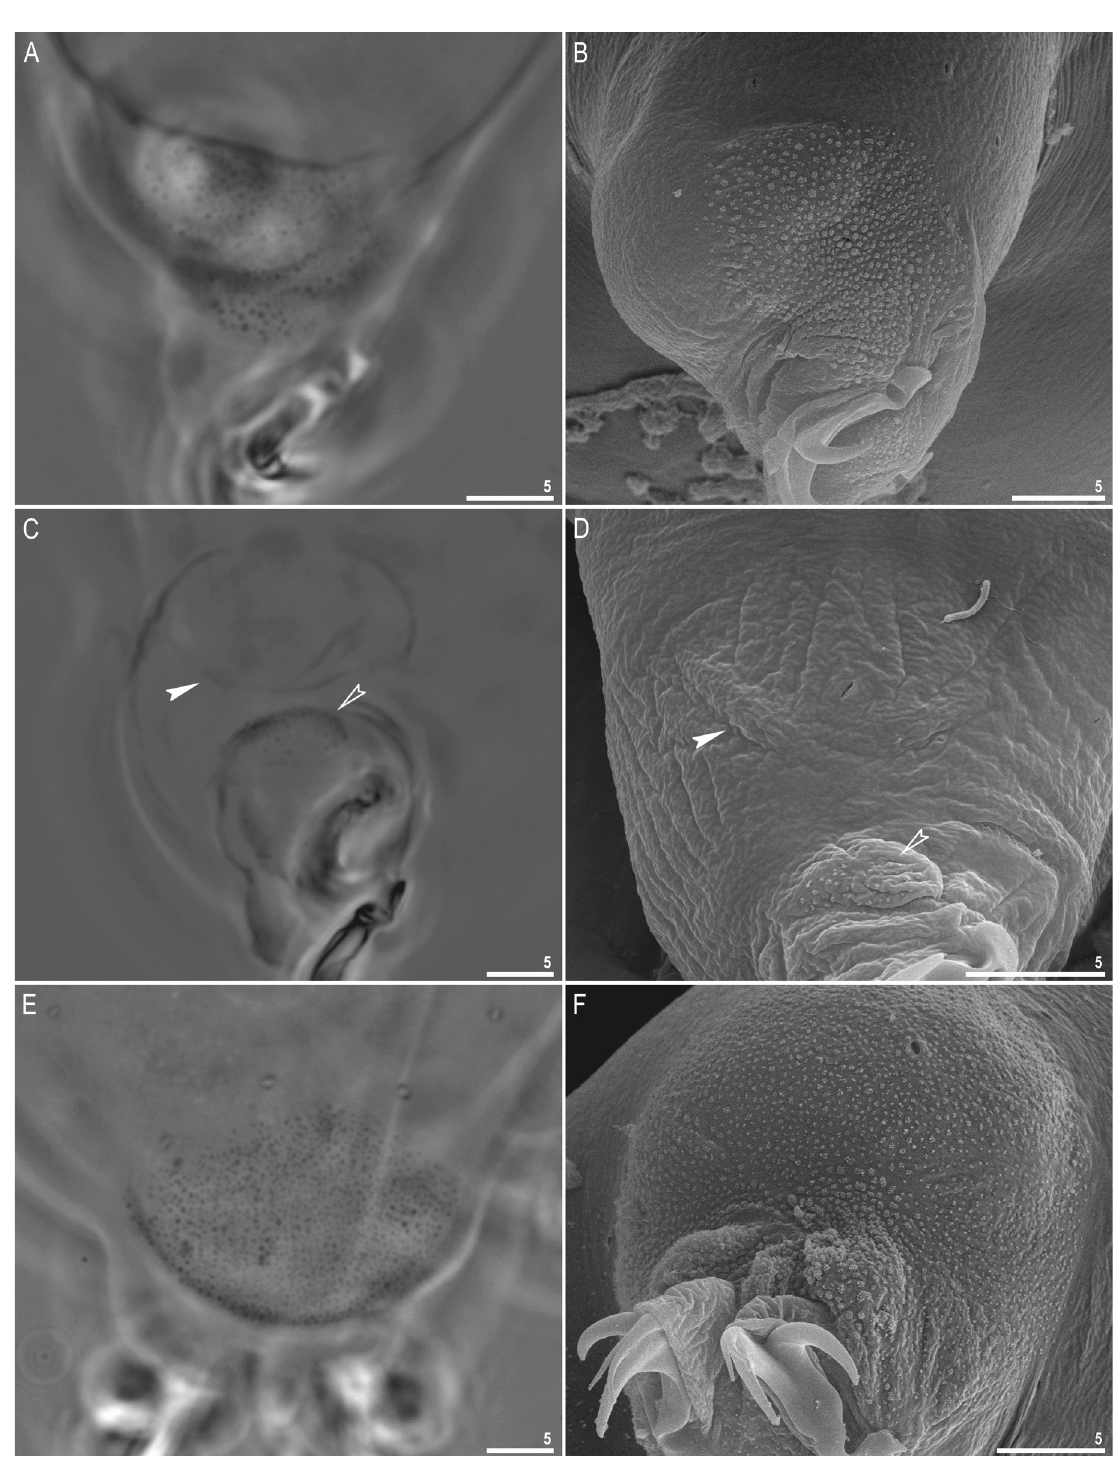
Fig. 2. Macrobiotus noongaris sp. nov., cuticular structures on legs (paratypes, IZiBB). A–B . External granulation on legs II and III seen in PCM (A) and SEM (B), respectively. C–D . A cuticular bulge (pulvinus) and a faint cuticular fold, covered by granulation, on the internal surface of legs I and III seen in PCM (C) and SEM (D), respectively. E–F . Granulation on leg IV seen in PCM (E) and SEM (F). Filled indented arrowheads indicate the cuticular bulge and empty indented arrowheads indicate the faint cuticular fold under the claws. Scale bars in